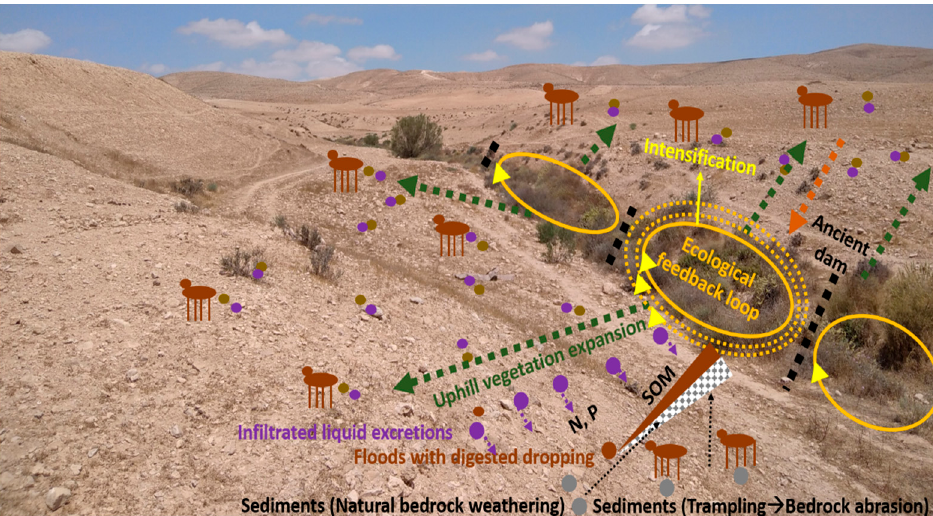
Figure 9. The proposed interrelation between the channel spatial patterns, the small ruminant excretion and trampling and the resulting land rehabilitation in the wadi (Transect 1). Brown circle—animal dropping; purple circle—animal fluid excretion; grey circles—sediments.